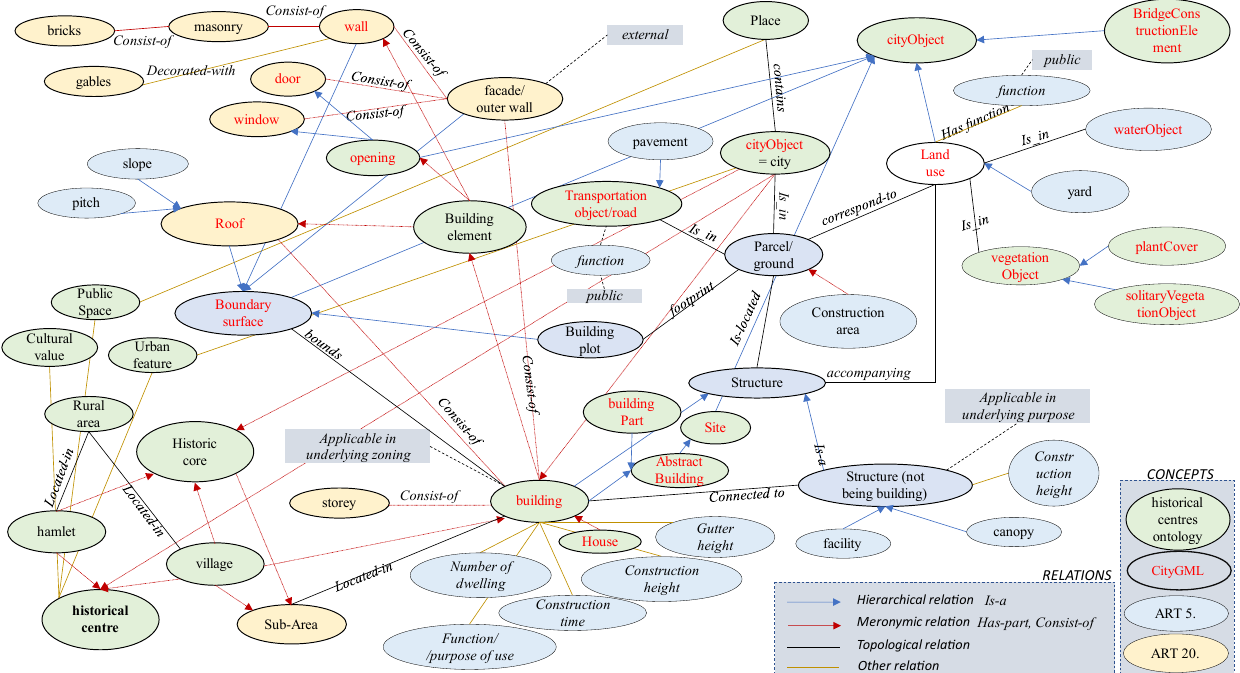
Figure 7. Ontological draft schema of classes and relations from Art.5, Art.20 of Zoning Plan of Sloten, the reference ontology of historical centres and the